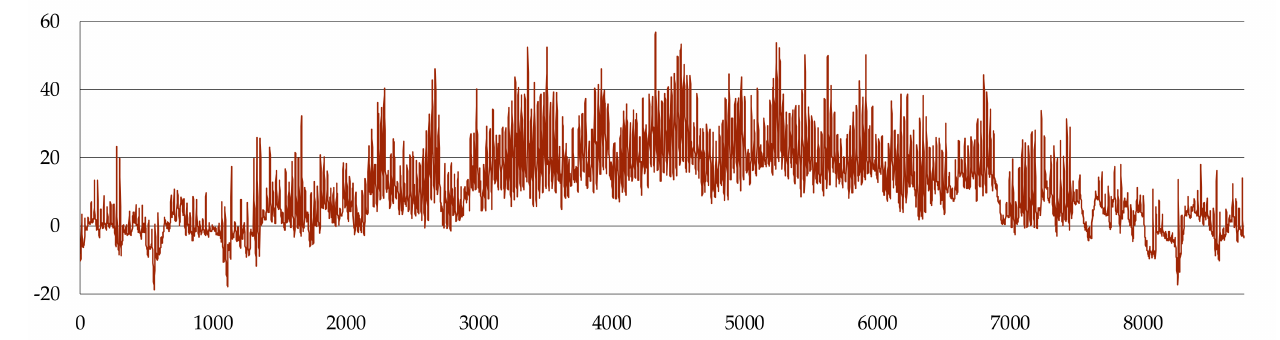
Figure 10. PV panel surface temperature ( ◦ C) during the typical meteorological year calculated on the basis of the ambient temperature, solar irradiance intensity, and wind speed for the Katowice meteorological station.